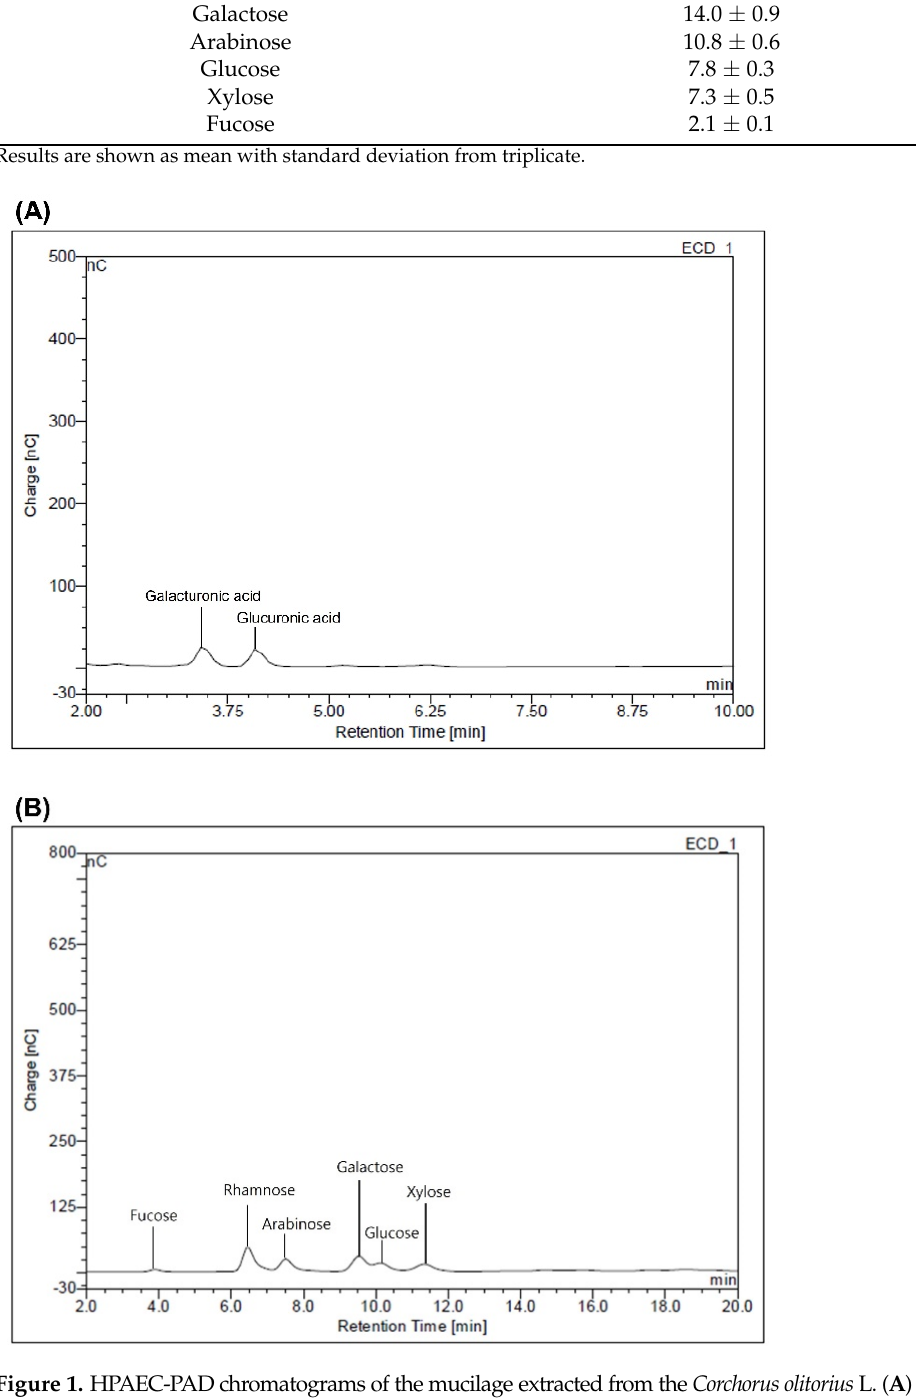
Figure 1. HPAEC-PAD chromatograms of the mucilage extracted from the Corchorus olitorius L. ( A ) uronic acid and ( B ) neutral sugars .